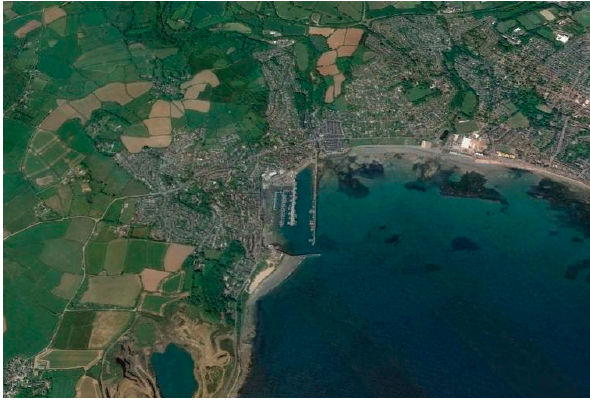
Figure 10. Selected image.